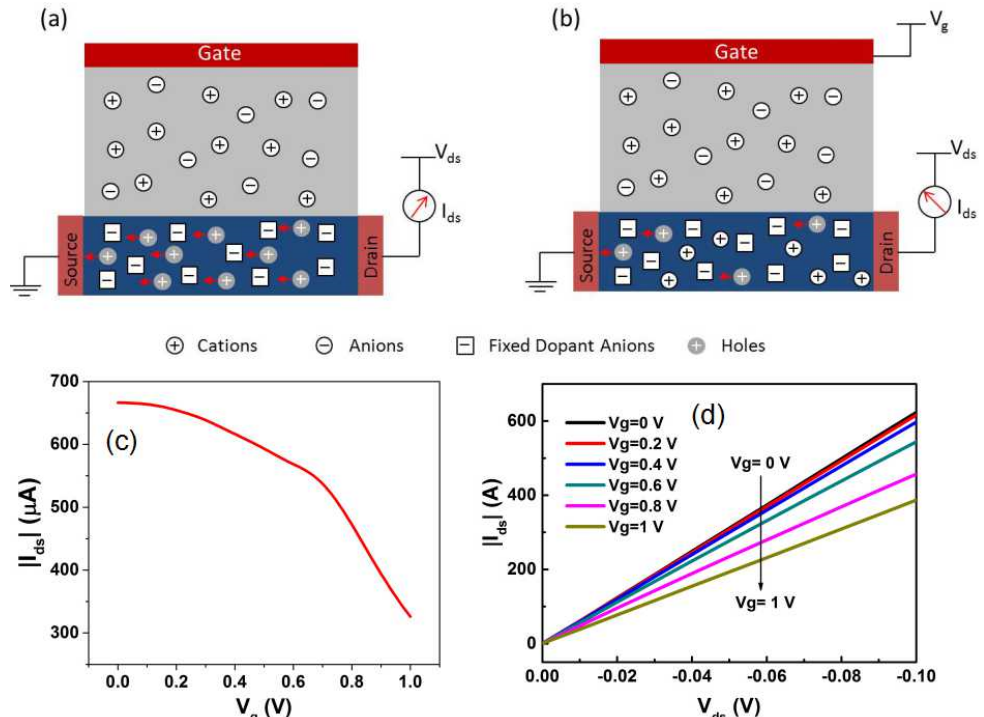
Figure 1. Schematic diagram of the working principle of an organic electrochemical transistor (OECT) device: ( a ) when no gate voltage is applied, poly(3,4-ethylenedioxythiophene) doped with poly(styrene sulfonate) (PEDOT:PSS) is conducting (ON state); ( b ) when a gate voltage is applied, the current is deceased due to the dedoping of the channel (OFF state). Typical transfer ( c ) and output ( d ) characteristics of an OECT measured in 0.1 M NaCl.